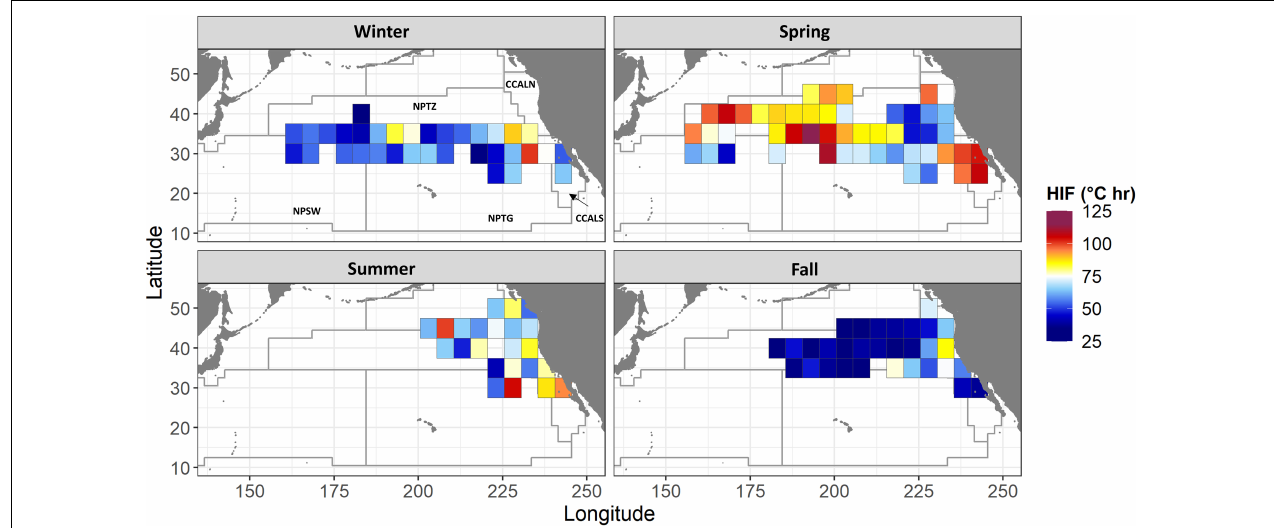
FIGURE 3 | Mean daily HIF by season at 5 × 5 degree resolution, 2003–2013. Only grid cells with data from at least two fish are plotted. Boundaries of modified Longhurst regions from Figure 1 are also shown.